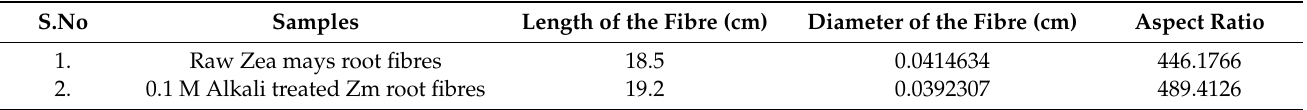
Table 2. Aspect ratio of Zm